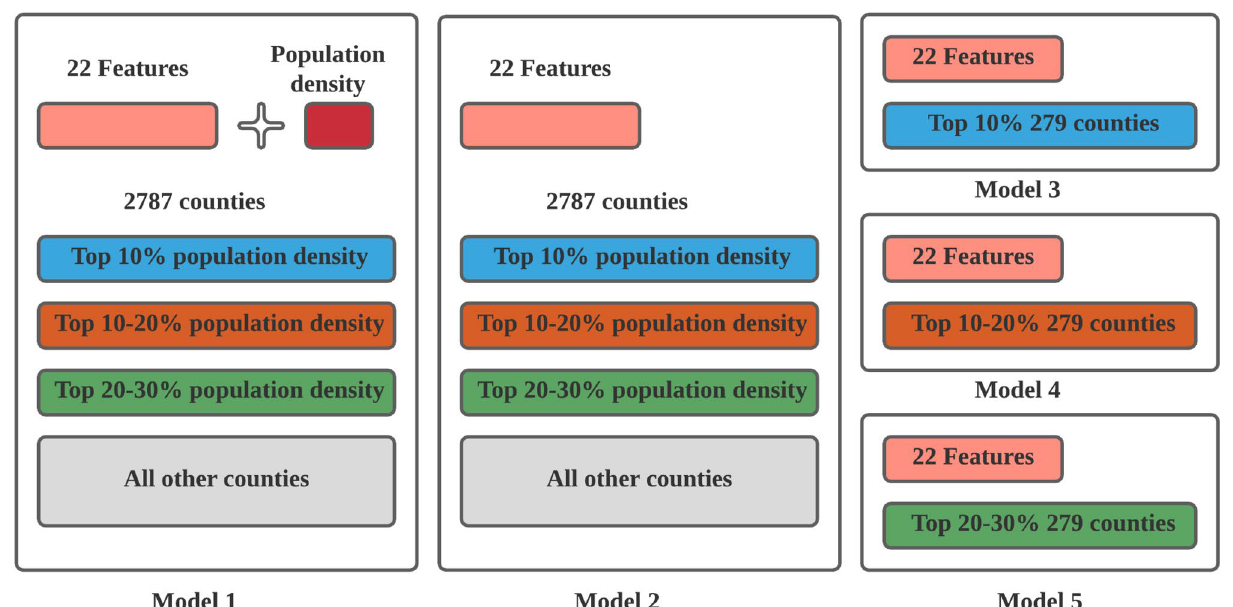
Figure 1. Features and counties included in five random forest models. Model 1 includes all counties and collected features. Model 2 includes all counties and features excluding population densities. Models 3, 4 and 5 include all features excluding population densities and counties with top 10%, 10–20%, and 20–30% population densities